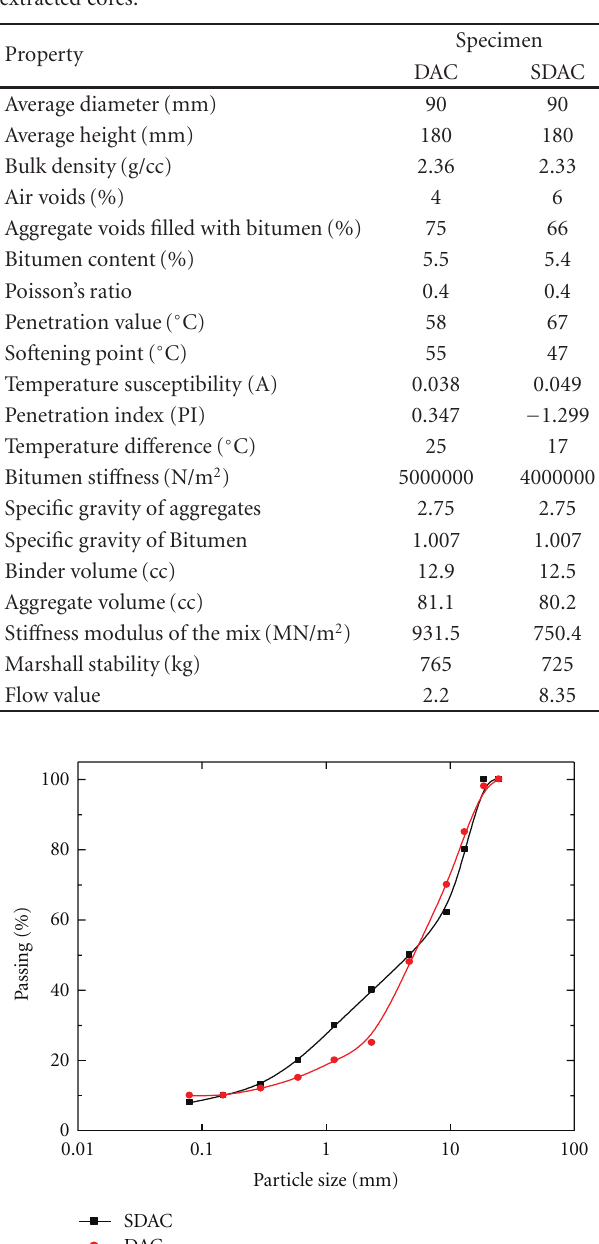
Table 1: Average properties of DAC and SDAC mix of extracted cores.